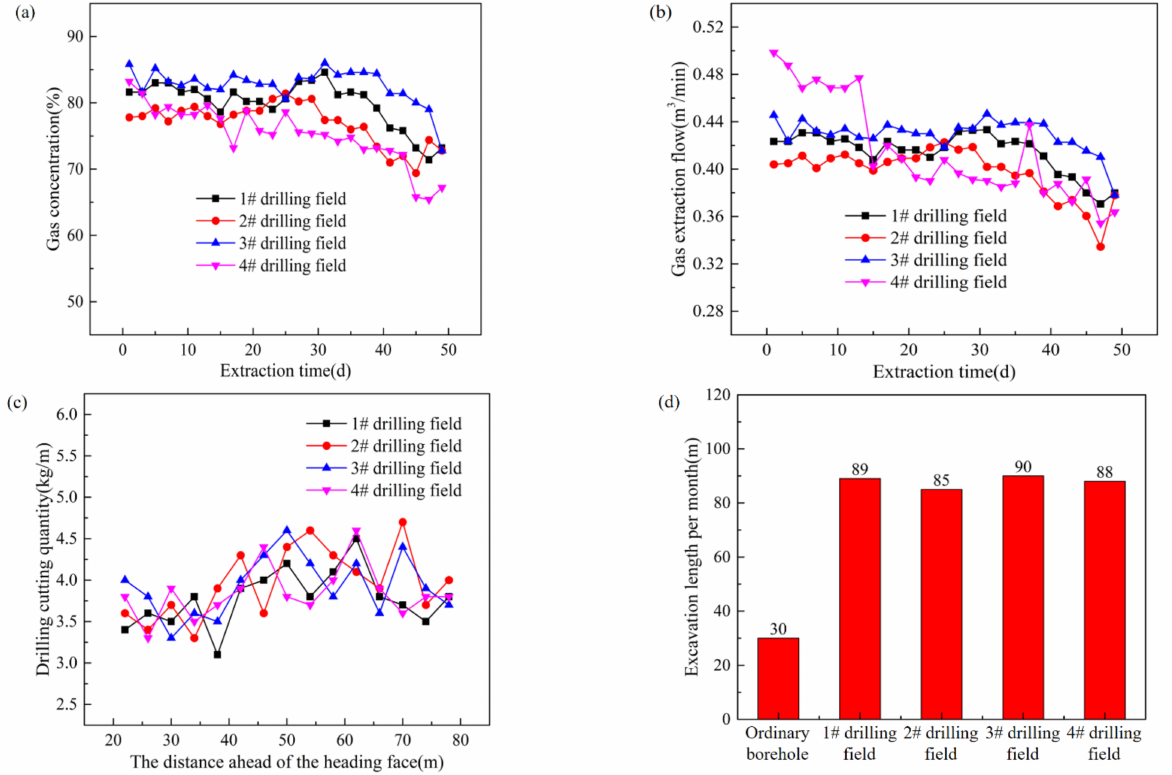
Figure 29. Analysis of gas drainage effect. ( a ) Gas drainage concentration. ( b ) Gas drainage flow. ( c ) Drilling cutting quantity. ( d ) Coal roadway excavation